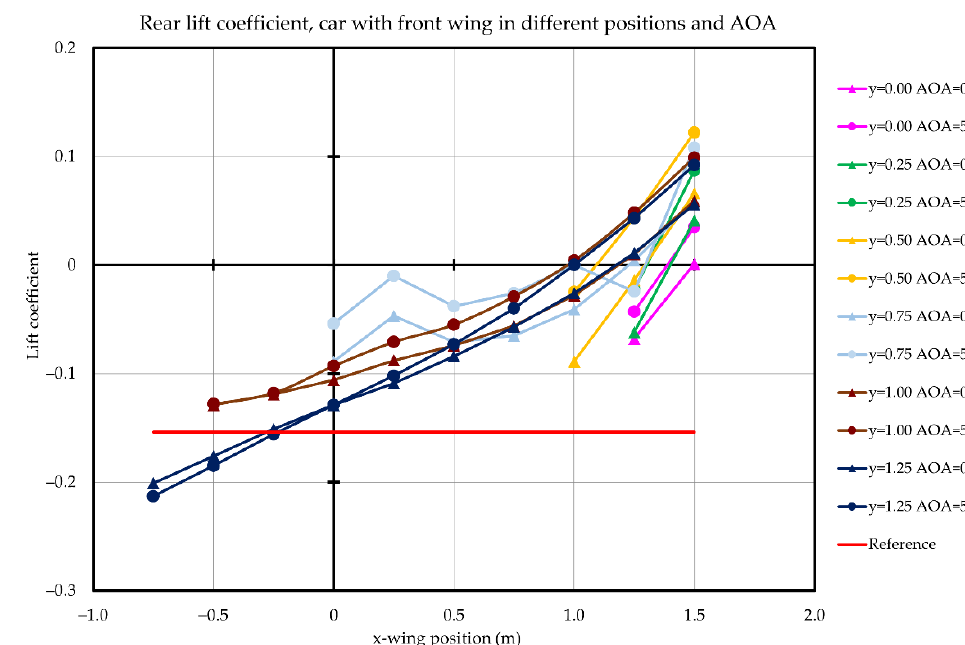
Figure 26. Variations in lift force acting on the rear axle of the vehicle as a function of wing position relative to the body and as a function of the angle of attack (AOA).